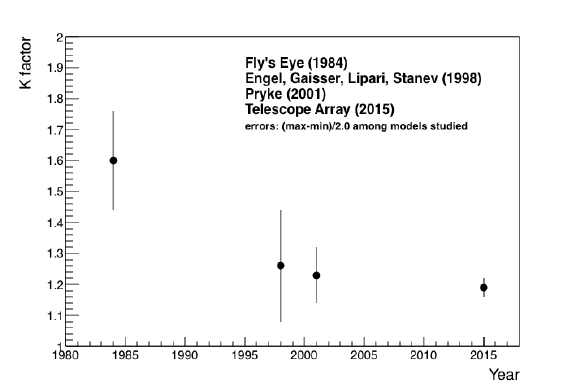
Figure 1. Historical improvement in the measurement of the K factor compiled for this review. The error bars are assigned as half of max-min uncertainties estimated in each paper ([7] [10] [11] [5] from left to right).